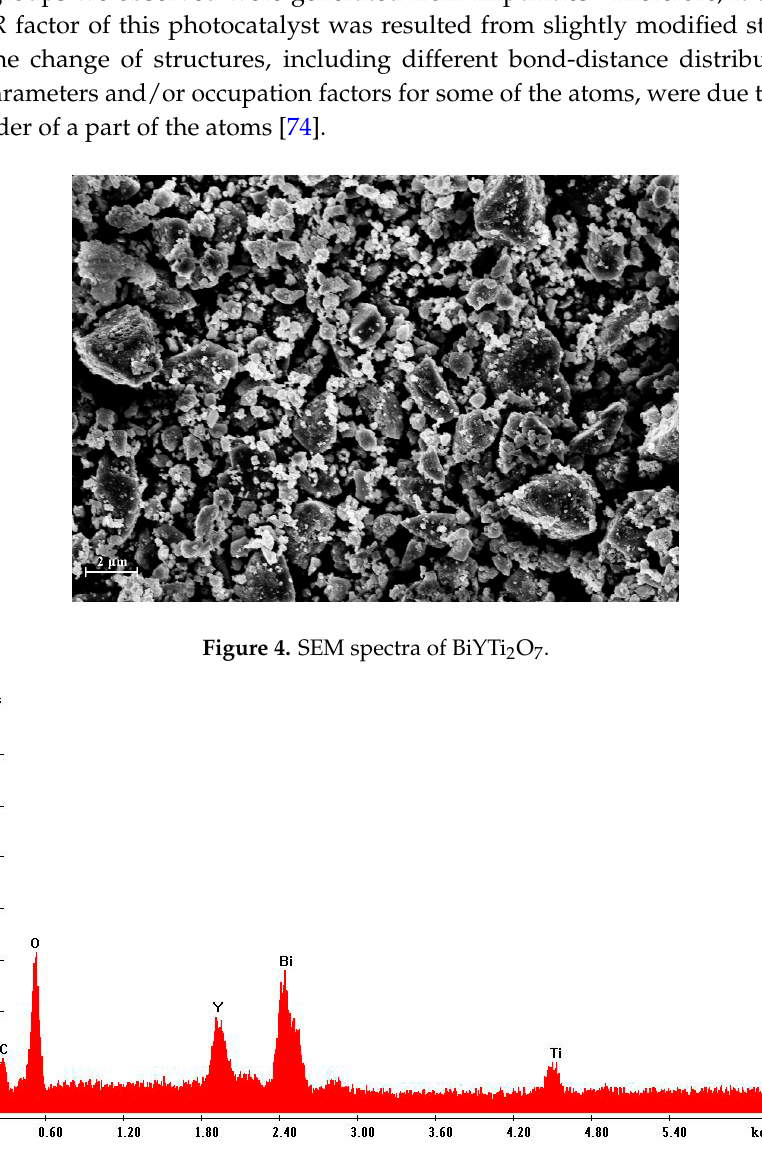
Figure 5. EDS spectra of BiYTi 2 O 7 .